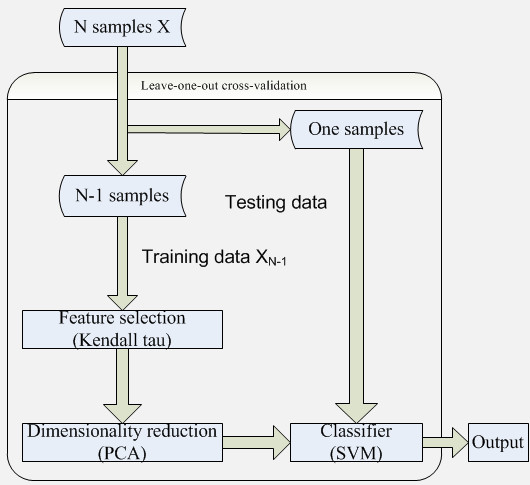
Flow chart of the algorithm.